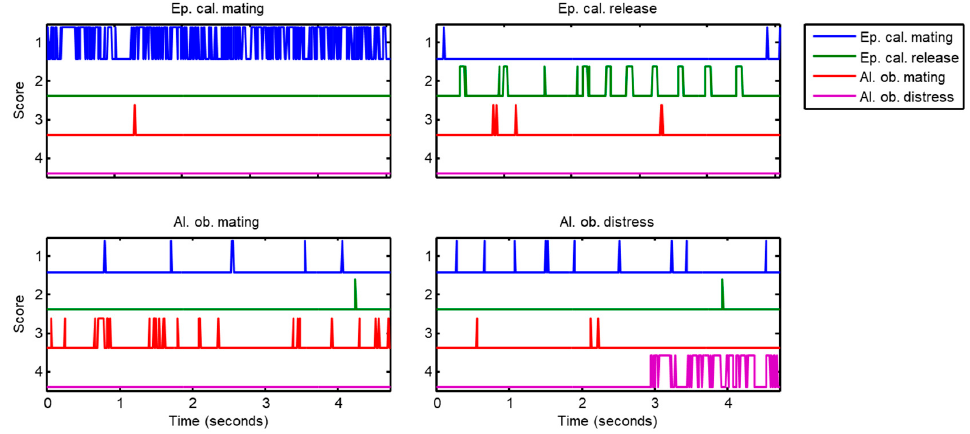
Figure 3. Score series of an example call for each sound class.